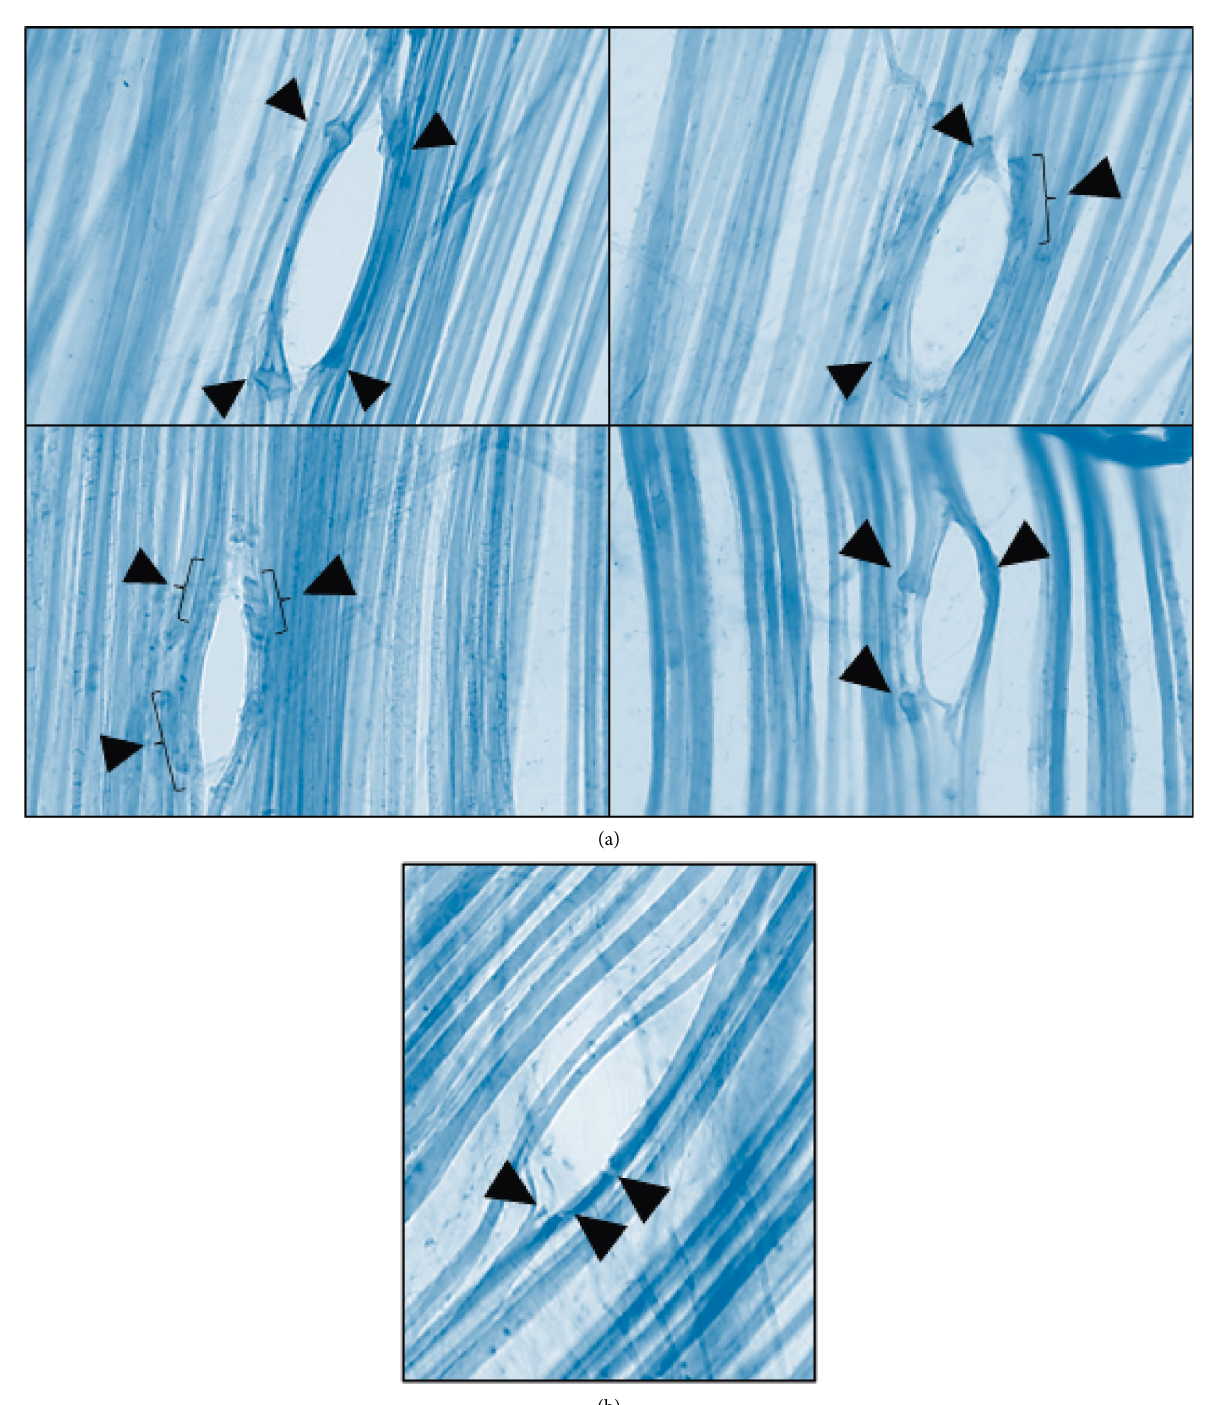
Figure 3: Ex vivo dry needling in contracted healthy LAL muscle. (a) Muscles were contracted with a calcium-rich depolarizing medium (KCl/CaCl 2 ). In the different examples, more injured fibers can be seen than in the muscles with fibers with contraction knots seen in Figure 2 (initial magnification: 200x). (b) After a more powerful contraction by immersing the muscles in formalin. The needle separates most of the fibers and only few of them are sectioned. Arrowheads, muscle fiber injury points. Bracket, area with various lesions (initial magnification: